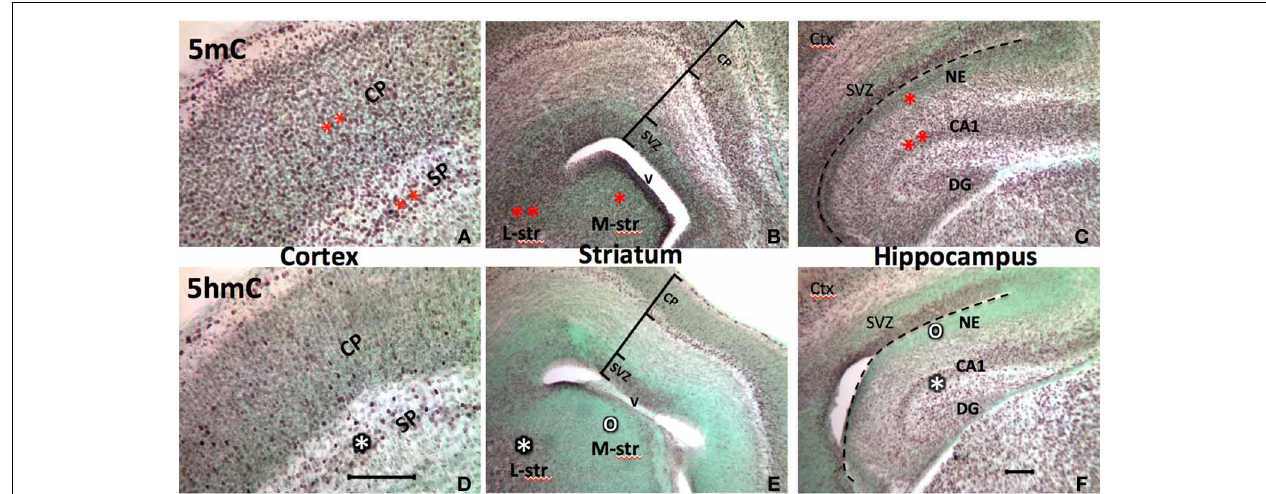
FIGURE 2 | Progression of the 5mC and 5hmC commonly parallels with the neuronal differentiation throughout the developing brain. Also, the sequential escalation of 5mC precedes 5hmC at the stage of neural differentiation in the cortex ( A vs. D ), striatum ( B vs. E ), and hippocampus ( C vs. F ) (The degree of methylation is shown by the number of stars, where lack of methylation is denoted by “o”). At the stage of early brain formation at E17, the 5mC appeared in the neuroepithelial cells preempting for differentiation (e.g., medial striatum and hippocampal neuroepithelium; B , C ,